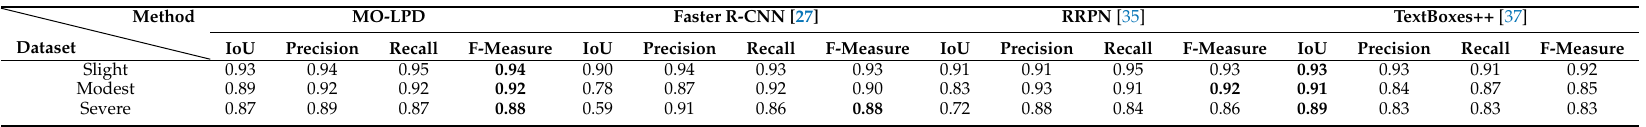
Table 2. Performance comparison between MO-LPD , Faster R-CNN [27], RRPN [35] and TextBoxes++ [37] on the “Slight”, “Modest” and “Severe” test subsets.